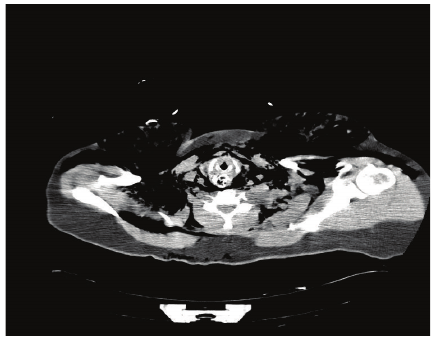
Figure 1: CT scan axial section showing the foreign body and subcutaneous emphysema.